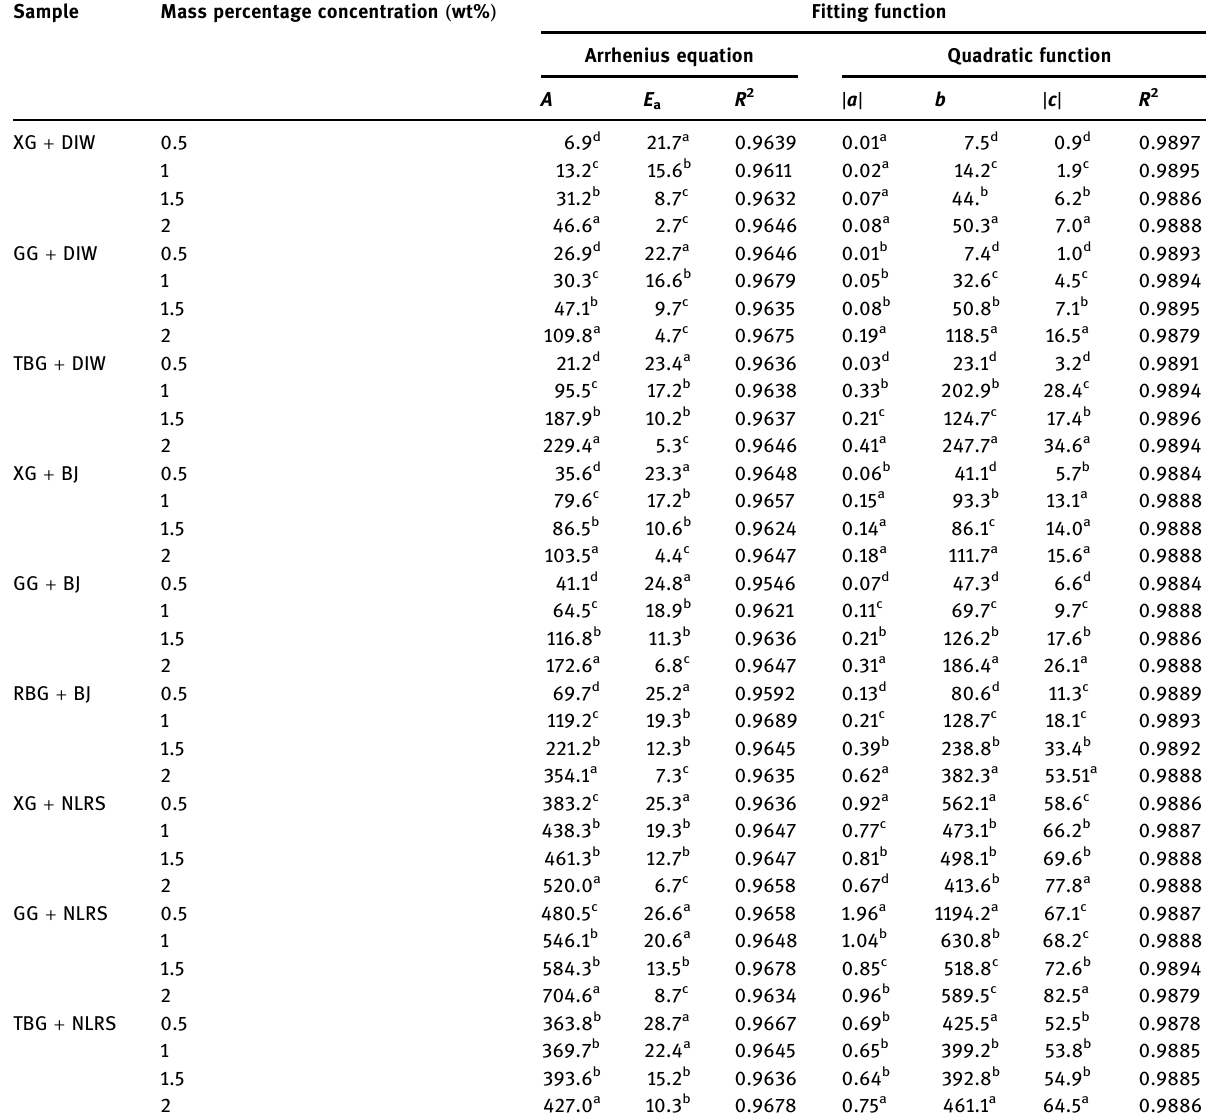
Table 6: E ff ect of concentration on Arrhenius and quadratic polynomial parameters